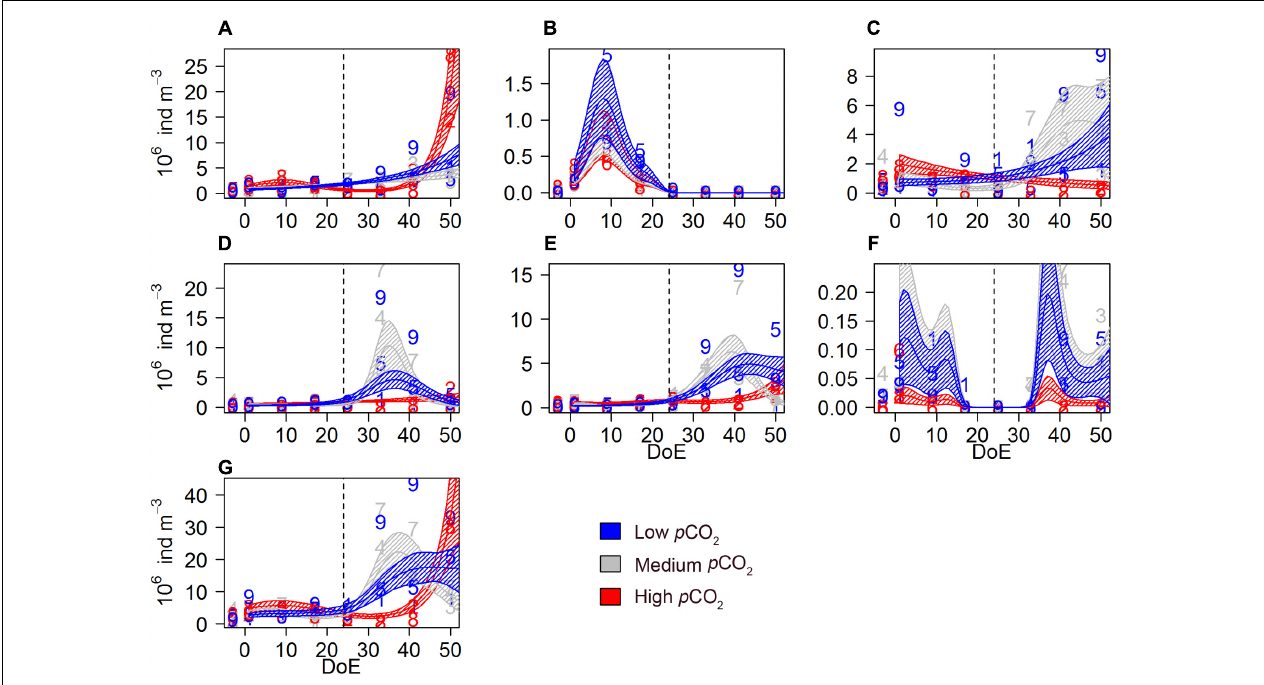
FIGURE 3 | Microzooplankton abundances during the study period. (A) aloricate ciliates, (B) loricate ciliates, (C) small athecate dinoflagellates ( < 25 µ m), (D) small thecate dinoflagellates ( < 25 µ m), (E) large athecate dinoflagellates ( > 25 µ m), (F) large thecate dinoflagellates ( > 25 µ m), (G) total microZP. Color code: blue = low- p CO 2 (M1, M5, and M9), gray = medium- p CO 2 (M3, M4, and M7), red = high- p CO 2 (M2, M6, and M8). DoE, day of experiment. Note that, for a better visibility of the data, y -axes have been adapted to abundances in each panel. Numbers represent abundances for the respective mesocosm (e.g., 9 for M9). Solid lines = prediction from Generalized Additive Mixed Models (GAMMs) (smoother trends p -value < 0.05); shaded area = confidence interval. Dashed line: t24, deep water